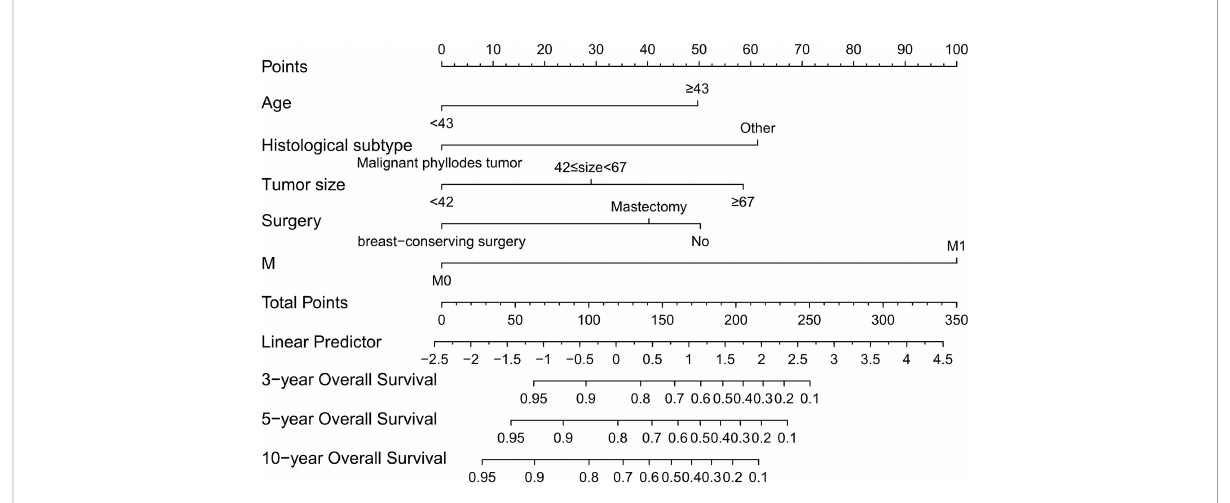
FIGURE 1 Nomogram that can predict the 3-, 5-, and 10-year overall survival of patients with primary breast sarcoma. M,